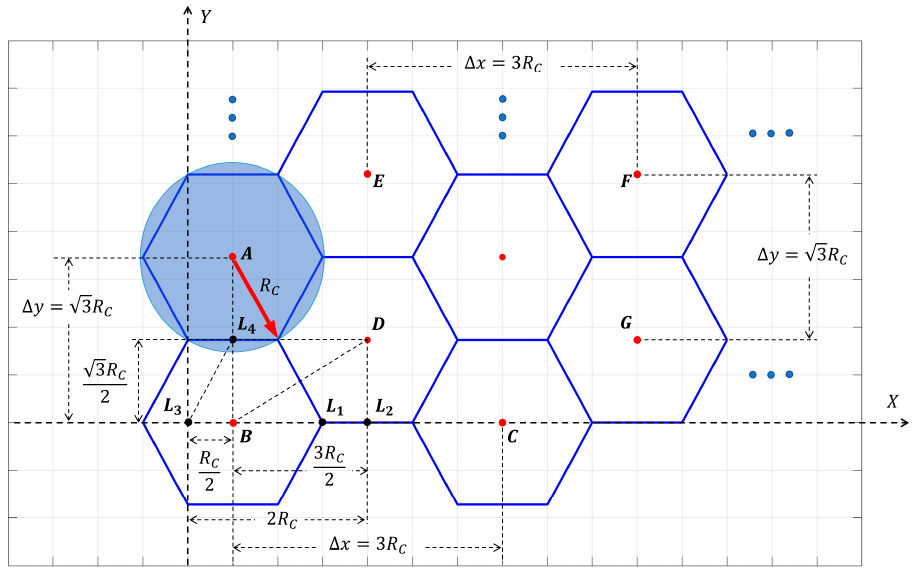
Figure 2. Stacking diagram: the reference cellular grids and the stacking interval when stacking a given area seamlessly with cellular grids.